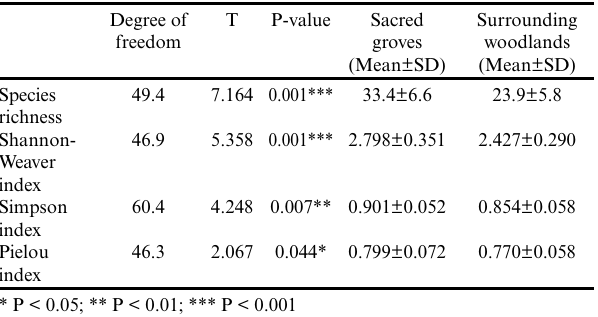
Table 1 . Student t-test results for species richness, Shannon, Simpson, and Pielou indices of sacred groves (32 relevés) and the surrounding woodlands (90 relevés).